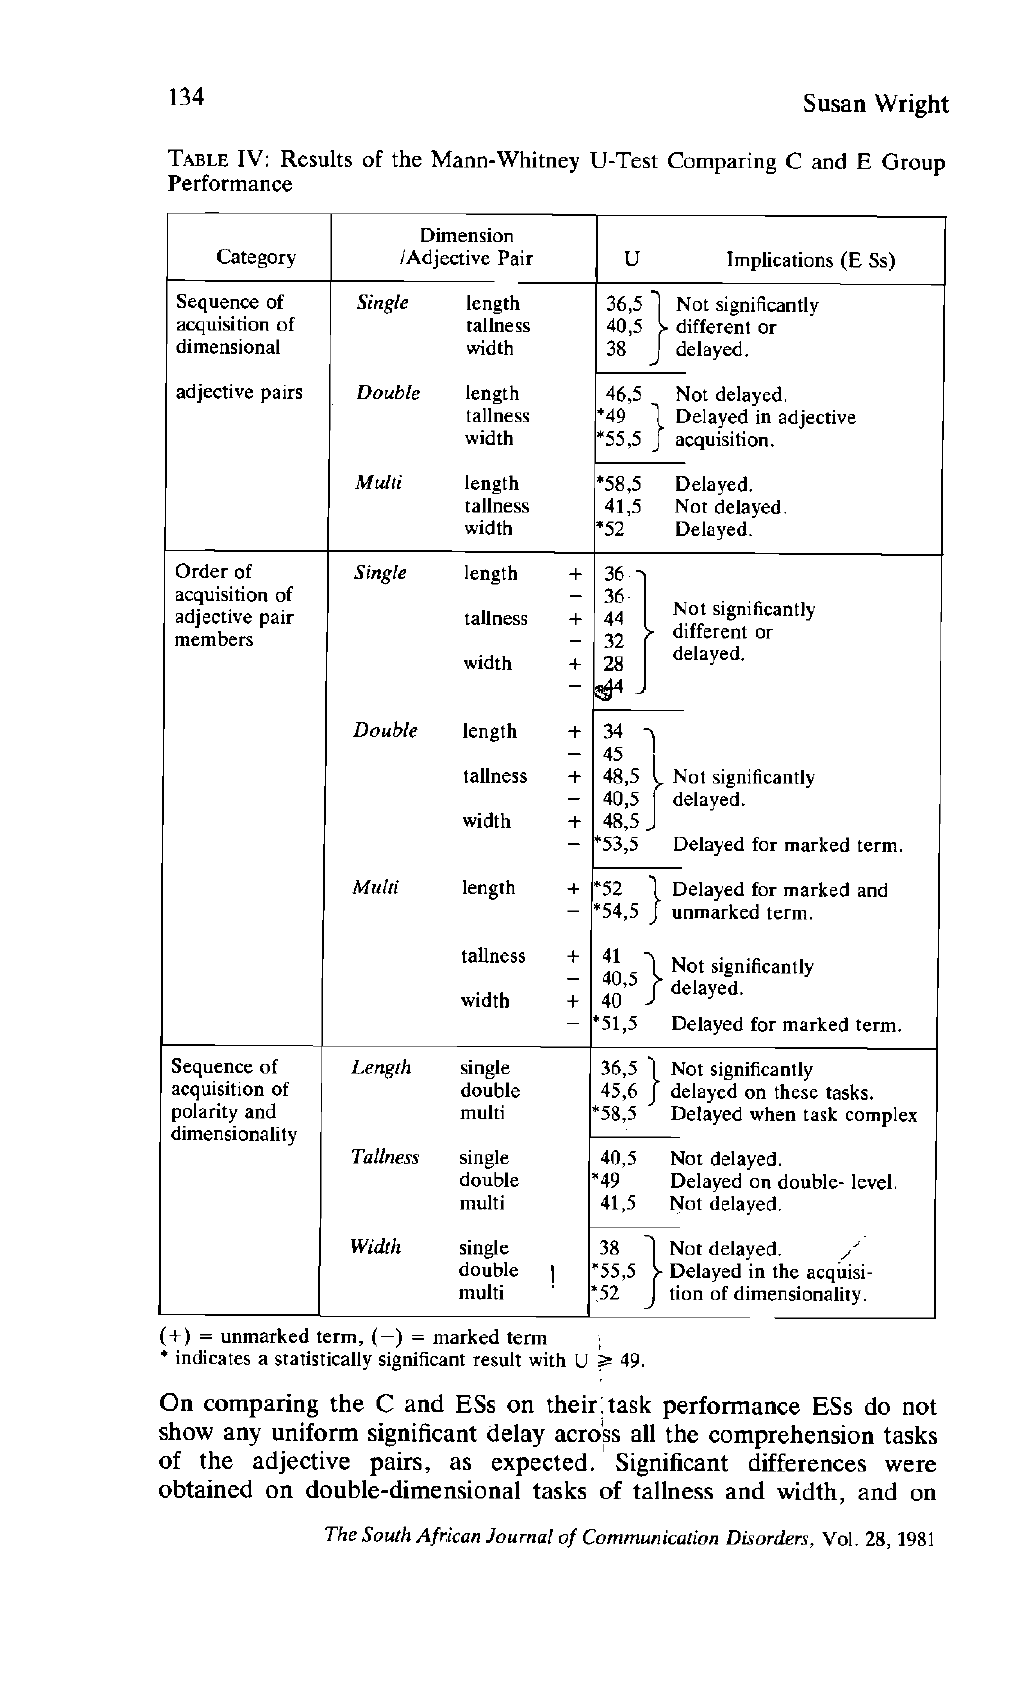
TABLE IV: Results of the Mann-Whitney U-Test Comparing C and Ε Group Performance